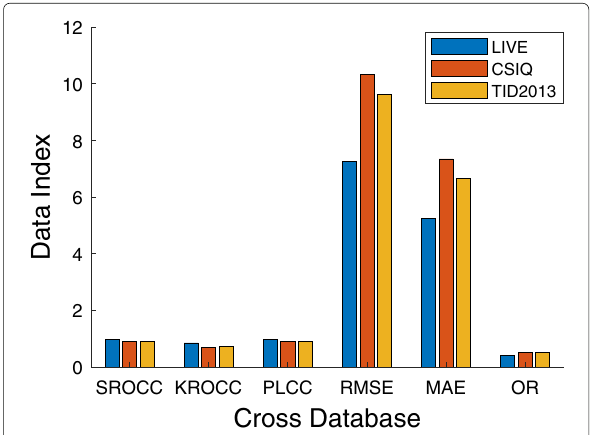
Fig. 4 Proposed EI-IQA cross-database result